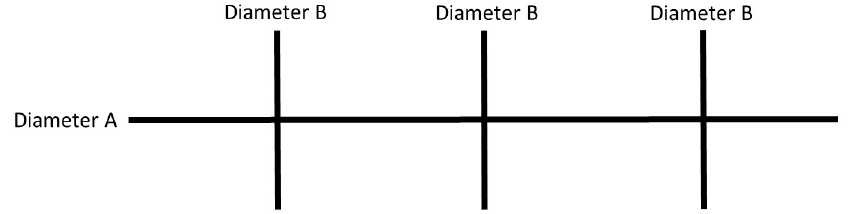
Figure 2. Configuration of the test pieces.